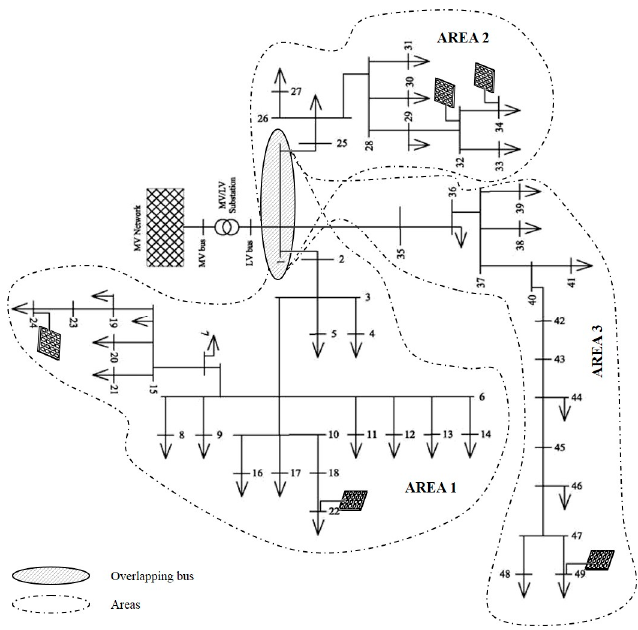
Figure 3. The single line diagram of the test distribution network.